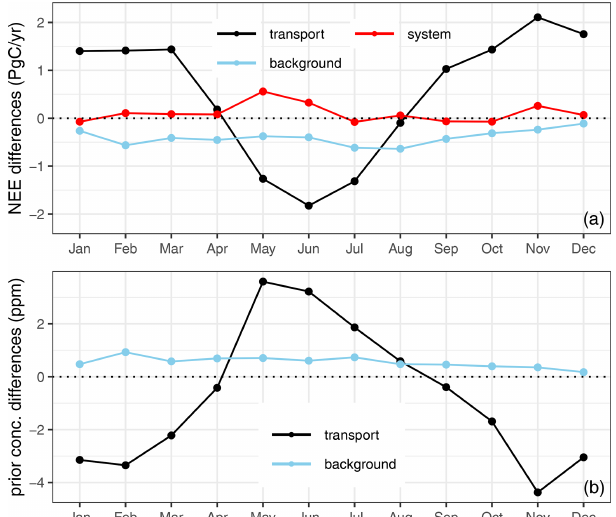
Figure 3. Differences in optimized fluxes (a) and prior concentra- tions (b) calculated with the regional transport models STILT and FLEXPART (CS3-CF3) and background provided through TM3 and TM5 (CS3-CS5). “system” refers to the differences between CSR and LUMIA inversion for optimized fluxes